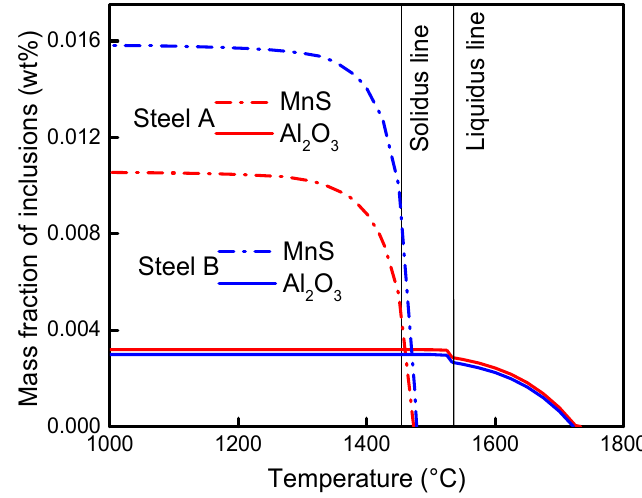
Figure 1. Simulation results of inclusions formation in liquid, solidified, and solid Steels A and B.